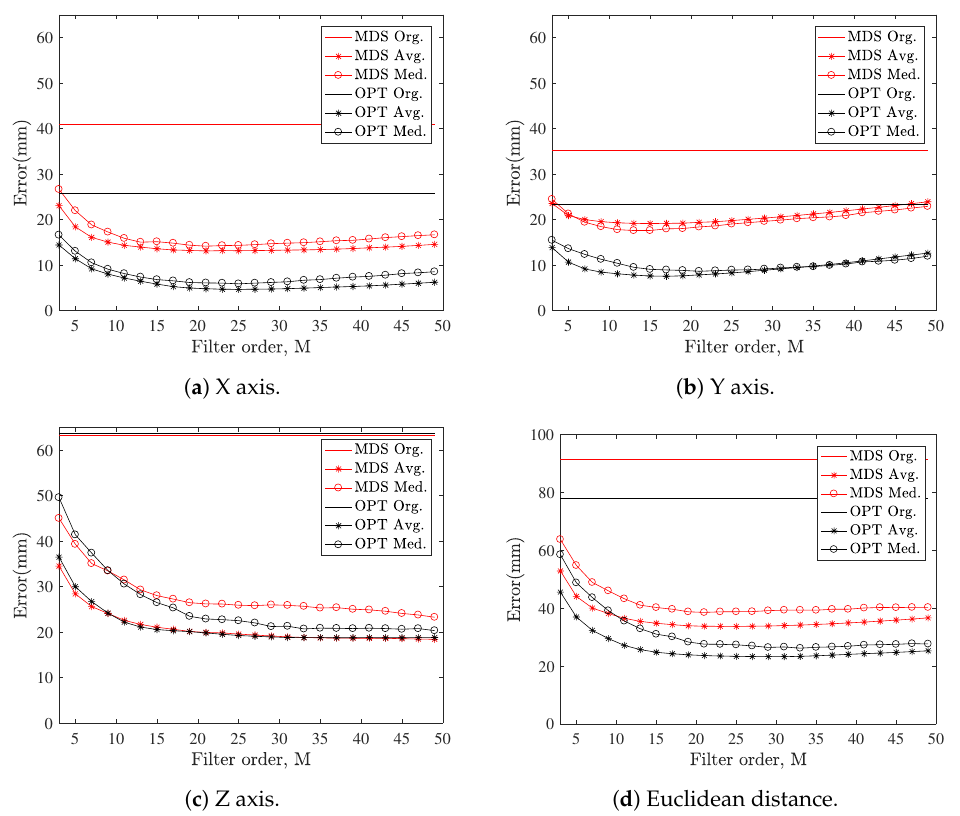
Figure 8. Comparison of the average trajectory error for the circle xy gesture, with a fixed noise level ( σ = 10 mm), with moving-median (Med.), moving-average (Avg.) smoothing filter and without (Org.) smoothing, for SMACOF MDS (MDS) and LM-BFGS optimization (OPT)